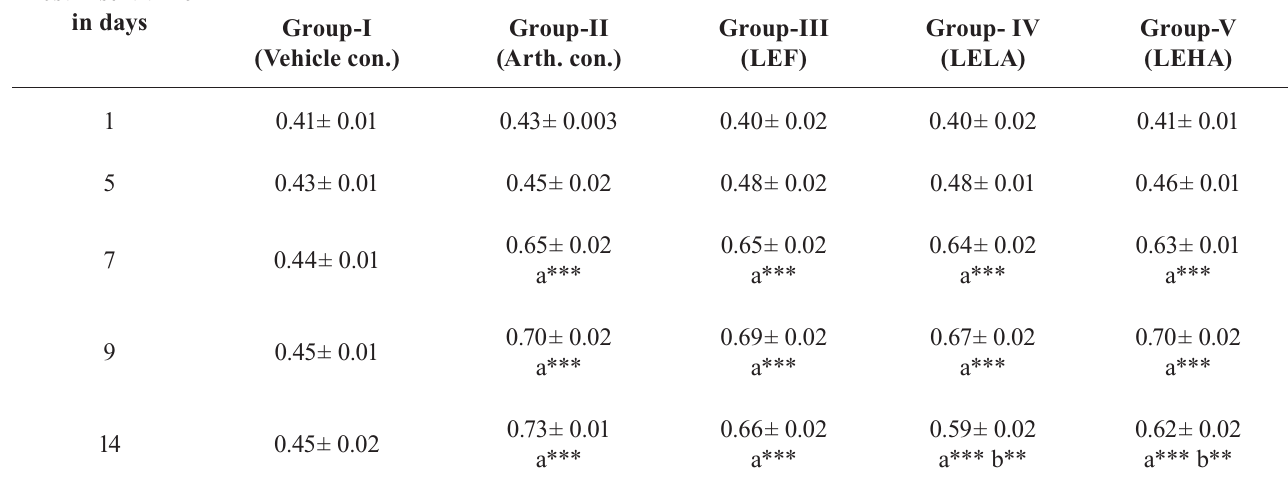
Mean changes in swelling volume (ml) ± SEM on injected paw Post insult time in days Group-I Group-II (Vehicle con.) (Arth.